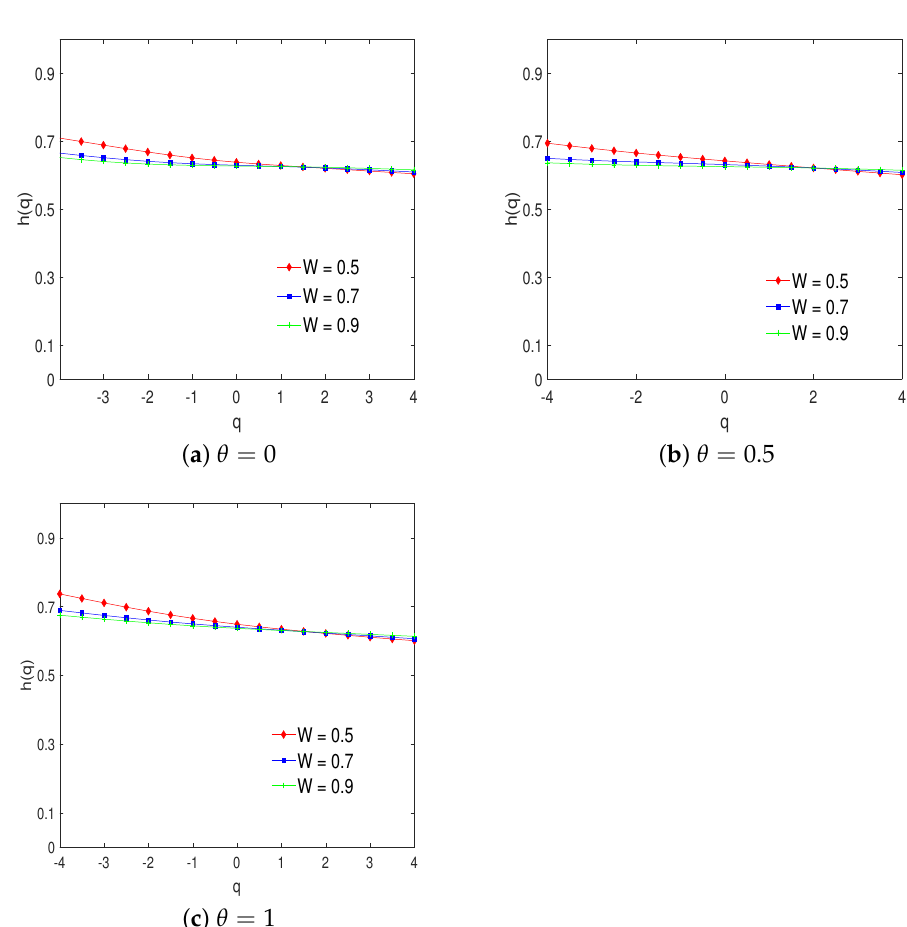
Figure 3. Correlated monofractal series: the scaling